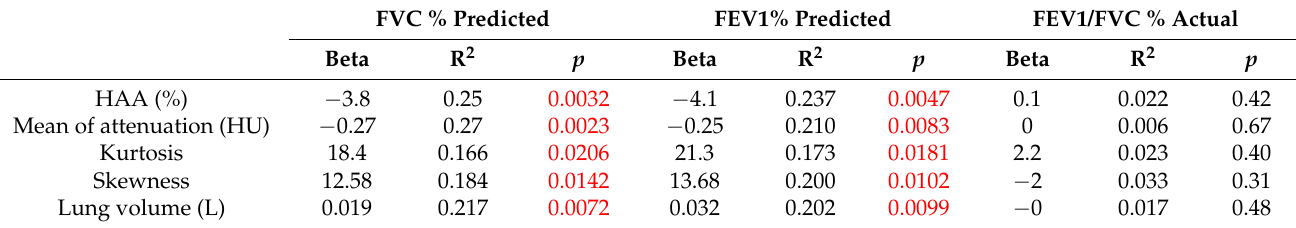
Table 3. Univariate regression analysis of the lung function test in FVC and FEV1 in response to quantitative lung parenchyma analysis